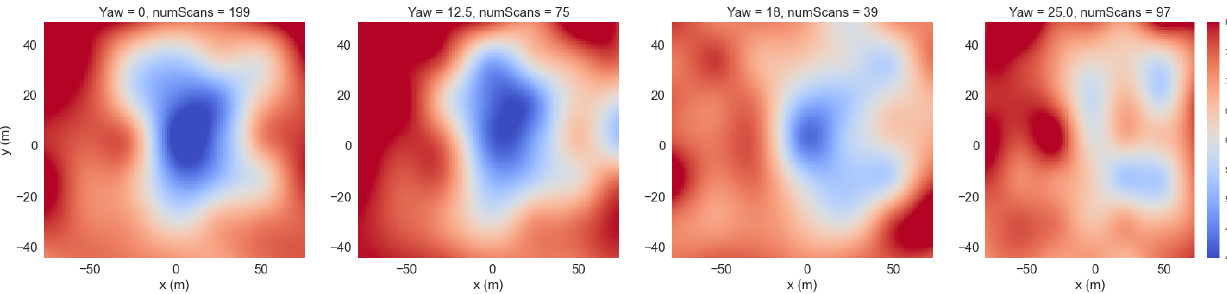
Figure 5. Lidar data at 180.95m downstream at different yaw misalignments ranging from 0 to 25 ◦ . The title of each plot indicates the yaw angle and the number of scans used to produce each time-averaged